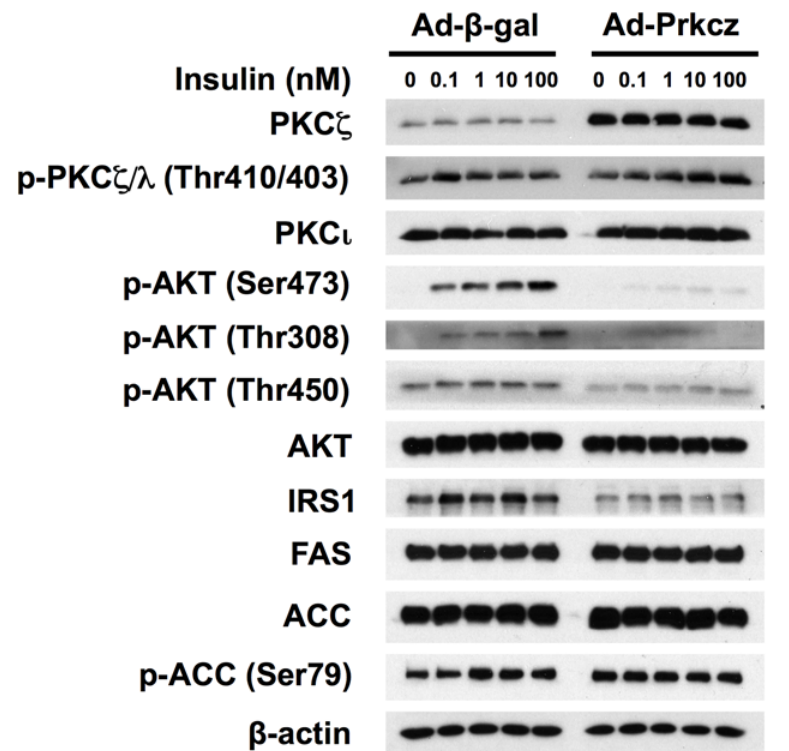
Fig 4. Overexpression of PKC ζ attenuated the activation of insulin signaling cascade in primary hepatocytes of ZL rats. Primary hepatocytes of ZL rats fed chow for 8 weeks were isolated and seeded onto dishes as described in the Materials and Methods. Purified Ad- β -gal and Ad-Prkcz were added in ZL primary rat hepatocytes during the overnight pretreatment period to allow the overexpression of β -GAL and PKC ζ , respectively. Cells were then incubated in fresh medium A with increasing concentrations of insulin (0 nM to 100 nM) for 15 min. The whole cell lysates were subjected to immunoblot analysis with antibodies against indicated proteins. The figure shows the representative result of three parallel experiments obtained from three sets of